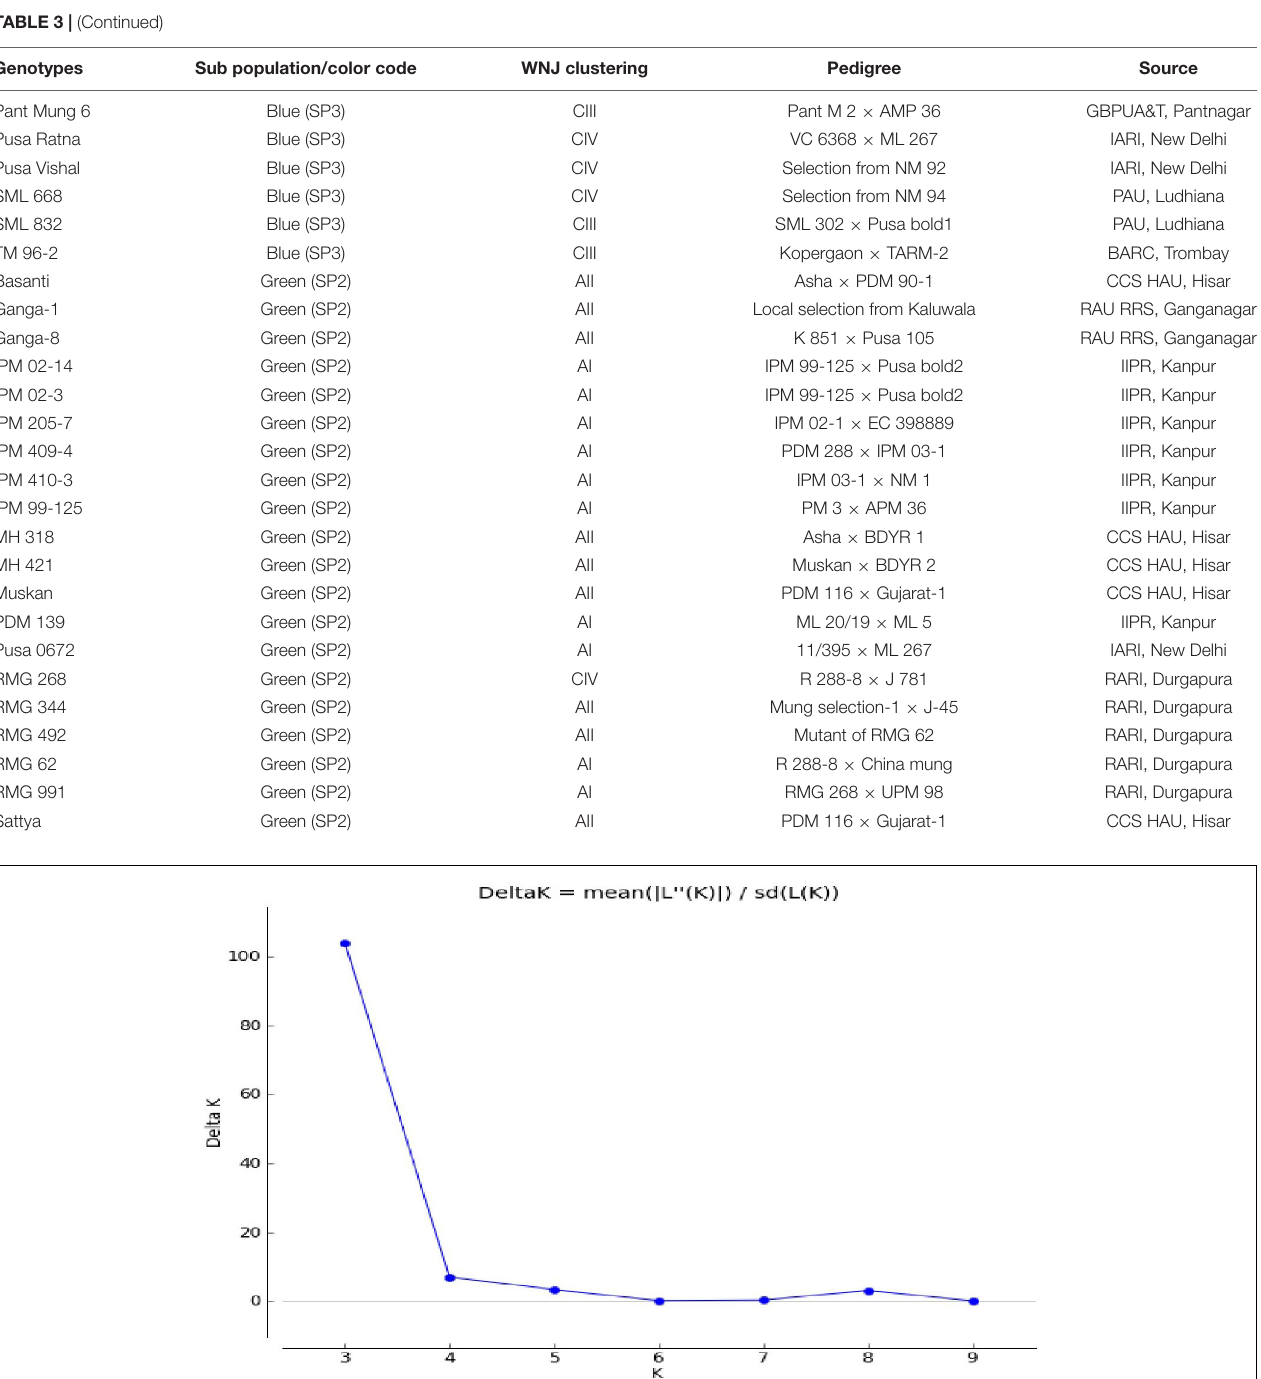
FIGURE 2 | Population estimation using LnP (D) derived (cid:49) k ( K = 2–10).